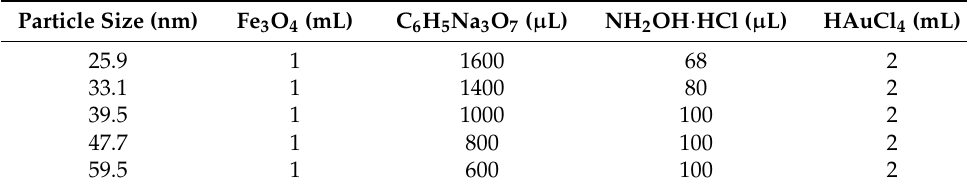
Table 1. Properties of different NP